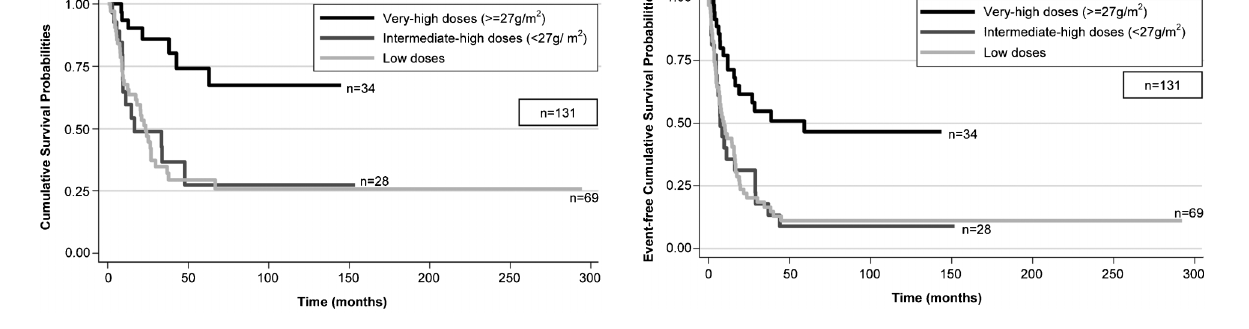
Figure 3. Overall survival of patients consolidated with cytar- abine, by total dose administered. P , 0.001, comparing different doses (log-rank test).